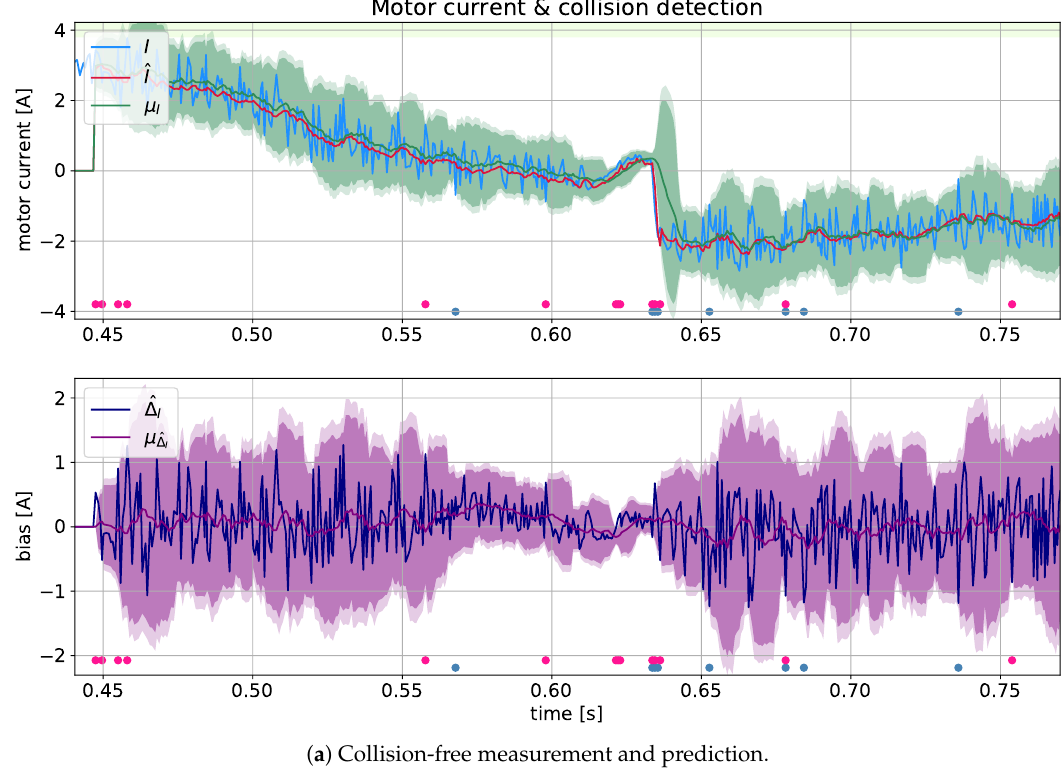
( a ) Collision-free measurement and prediction. Figure 6.